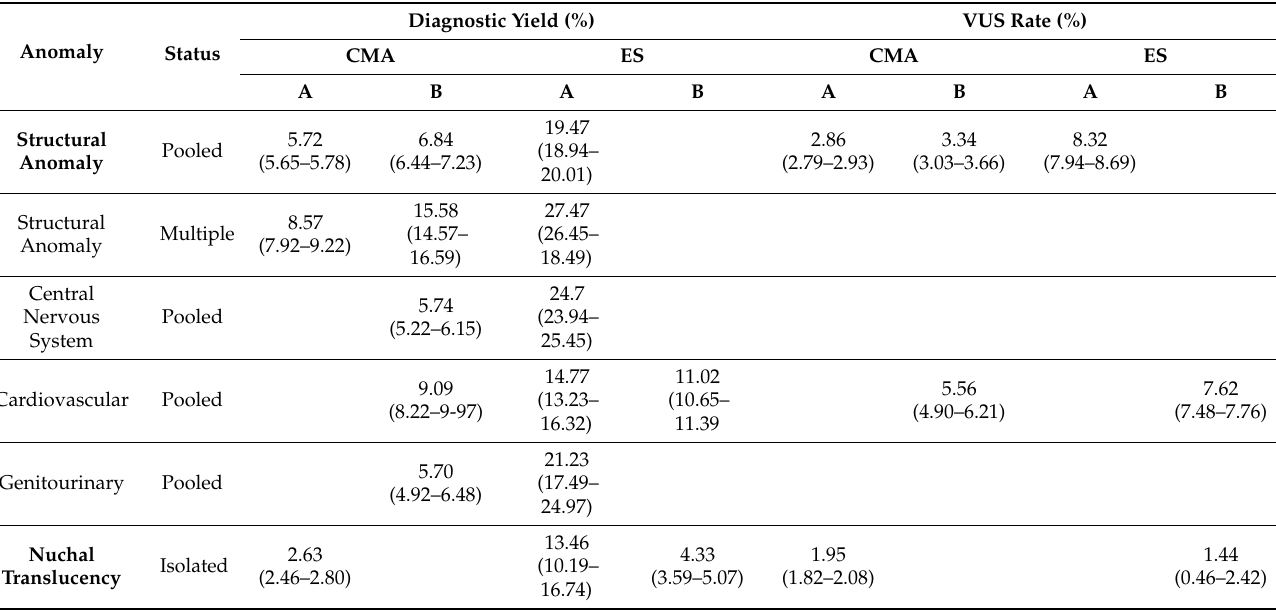
Table 4. CMA and ES comparison: detection rates and VUSs